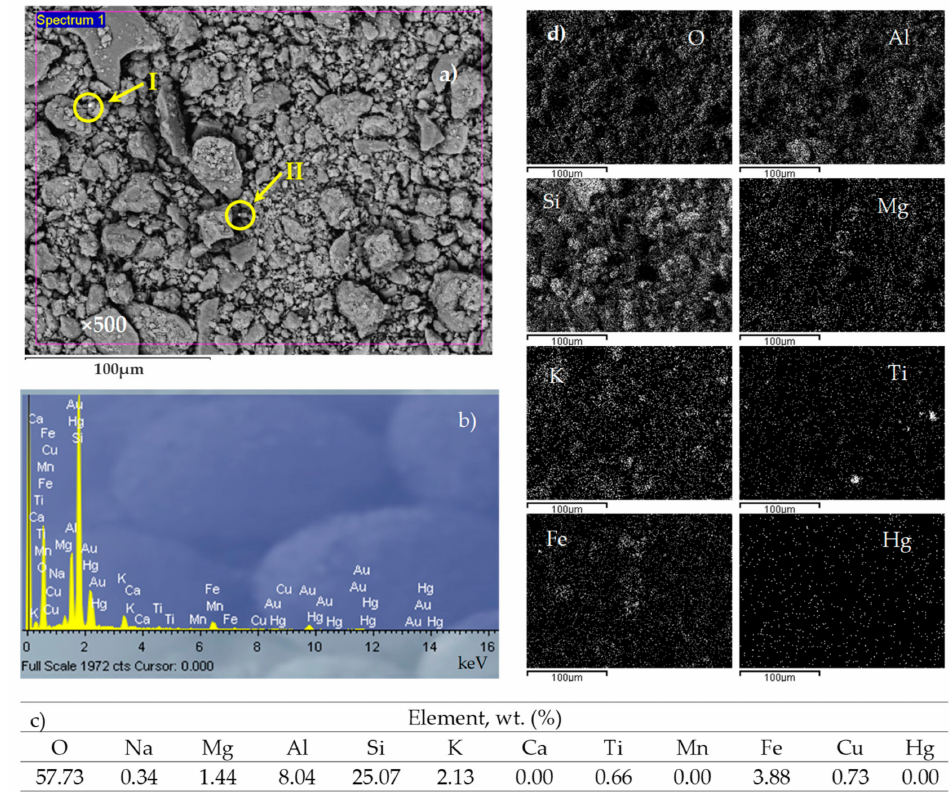
Figure 1. ( a ) SEM image, ( b ) EDS peaks of elements over the entire surface (Spectrum 1), ( c ) element content in wt. (%) over the entire surface and ( d ) distribution of main elements and mercury (Hg) over the entire surface.